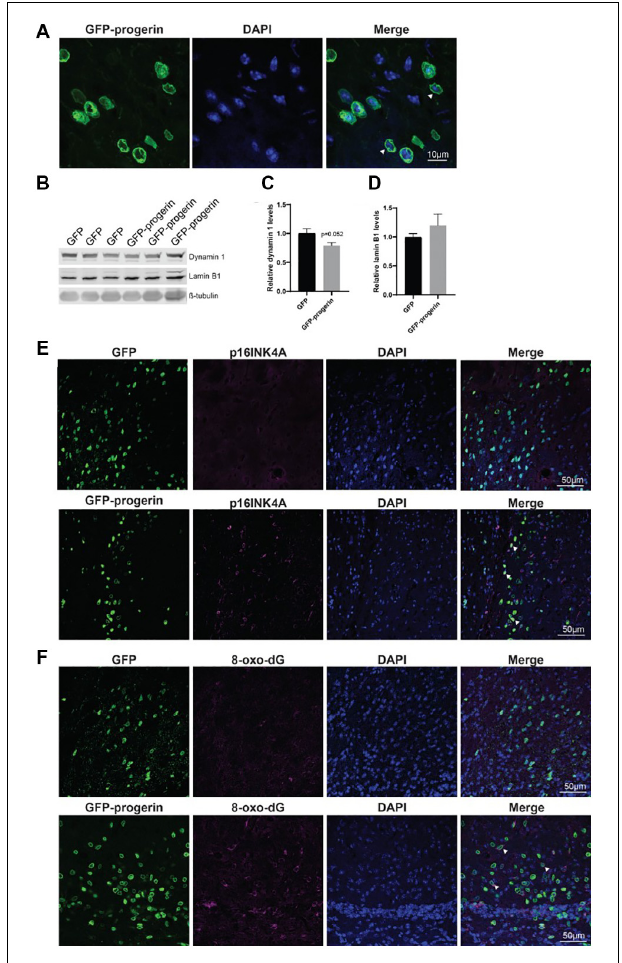
FIGURE 7 | Progerin treatment induces aging and DNA damage in the HD mouse brain. (A) Representative confocal image of the YAC128 brain treated with AAV2/1-GFP-progerin shows nuclear blebbing. Scale bar = 10 µ m. Representative Western blots (B) and quantifications of aging markers (C) dynamin 1 and (D) lamin B1. Error bars ± SEM. (E,F) Confocal images of (E) p16 INK4A or (F) 8-Oxo-dG staining in the YAC128 mouse brain treated with either GFP or